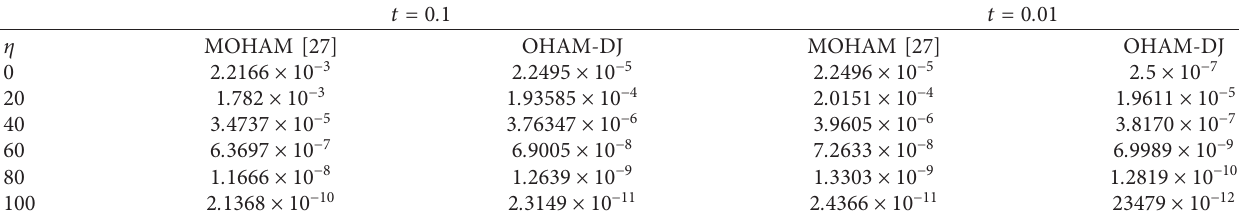
Table 3: Absolute errors obtained by first order OHAM-DJ and comparison is made with MOHAM of w ( η ,t ) at t � 1 , ω � 1 . 5 ,l � 0 . 1 ,C